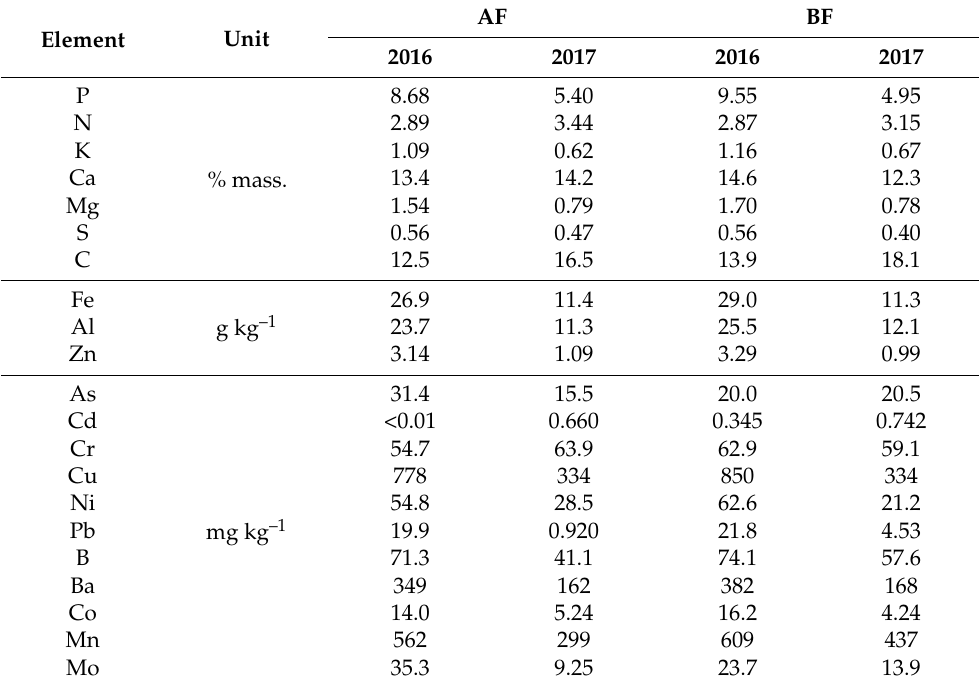
Table 1. Elemental composition of the biobased fertilizers under study 1 . Element